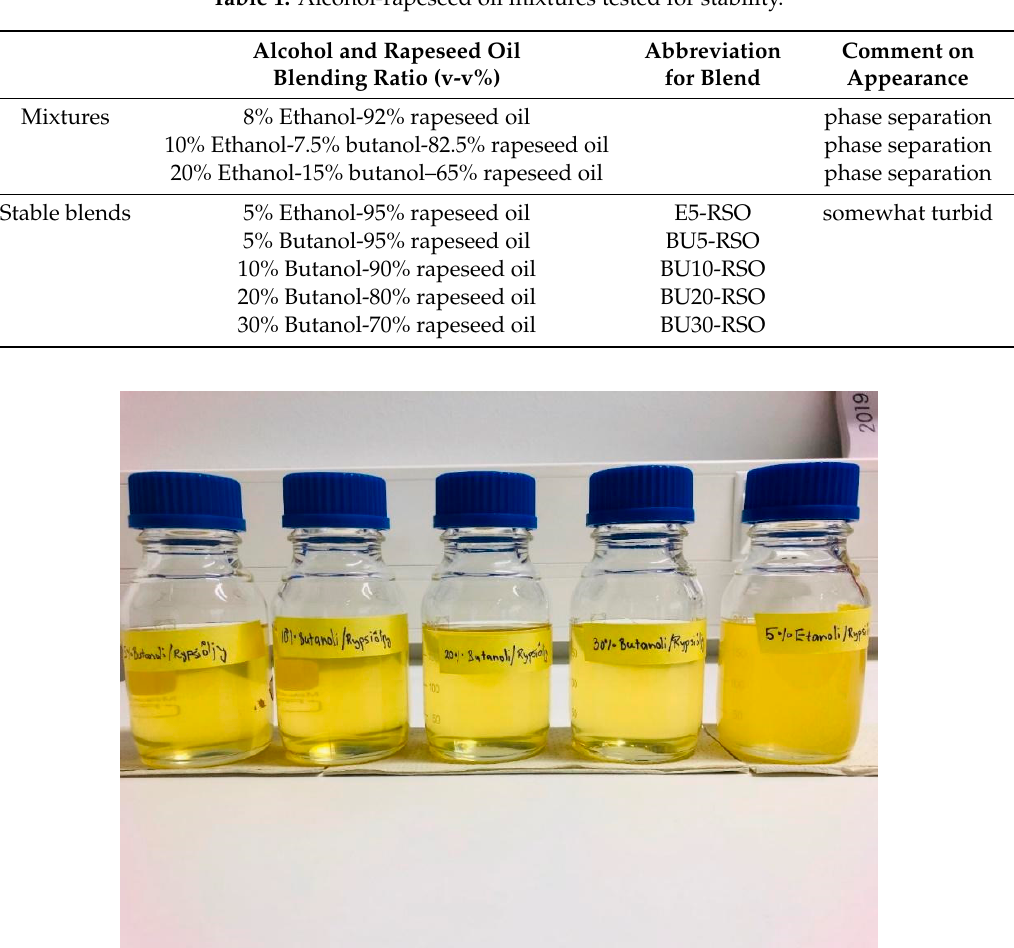
Figure 1. Ready blends (from left to right) of BU5-RSO, BU10-RSO, BU20-RSO, BU30-RSO and E5-RSO (photograph by Riikka Help).